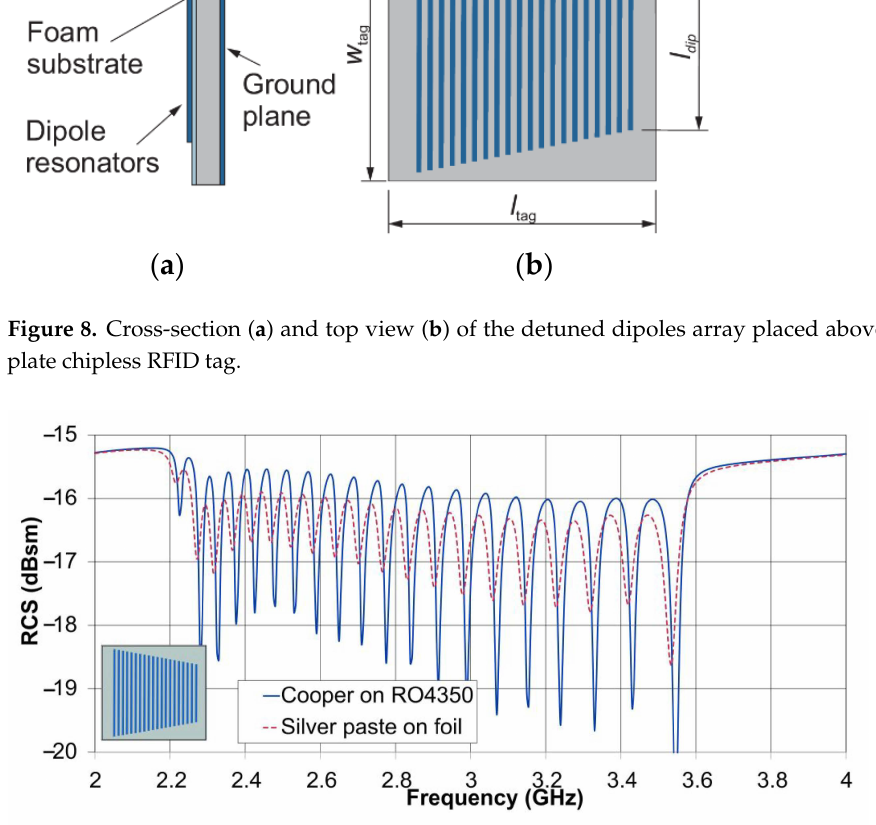
Figure 9. Simulated RCS of the array of detuned planar dipoles closely coupled to a rectangular metallic plate.